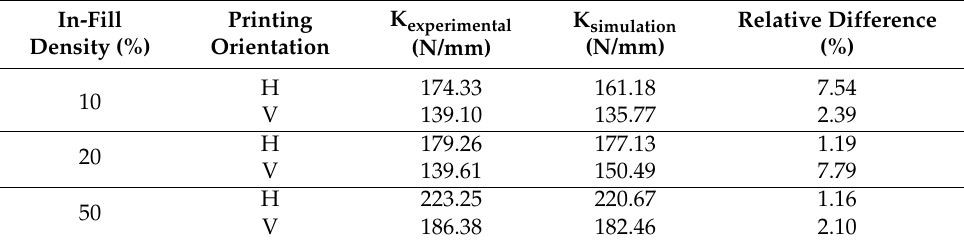
Table 5. Comparison between experimental and simulation results for the square cross-section bending test (ABS/PC